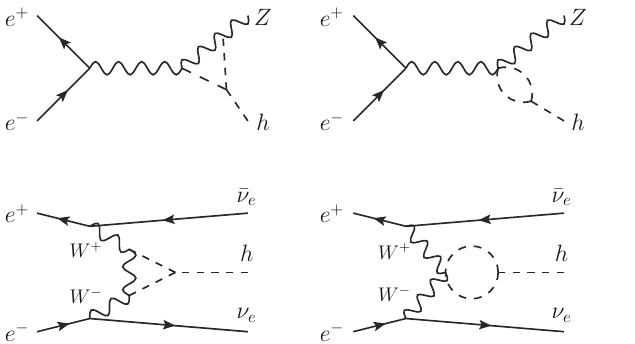
Fig. 10.2 From Ref. [288], sample Feynman diagrams illustrating the effects of the Higgs trilinear self-coupling on single Higgs process at next-to-leading order Fig. 10.3 Indirect measurements of the Higgs self-coupling at FCC-ee combining runs at different